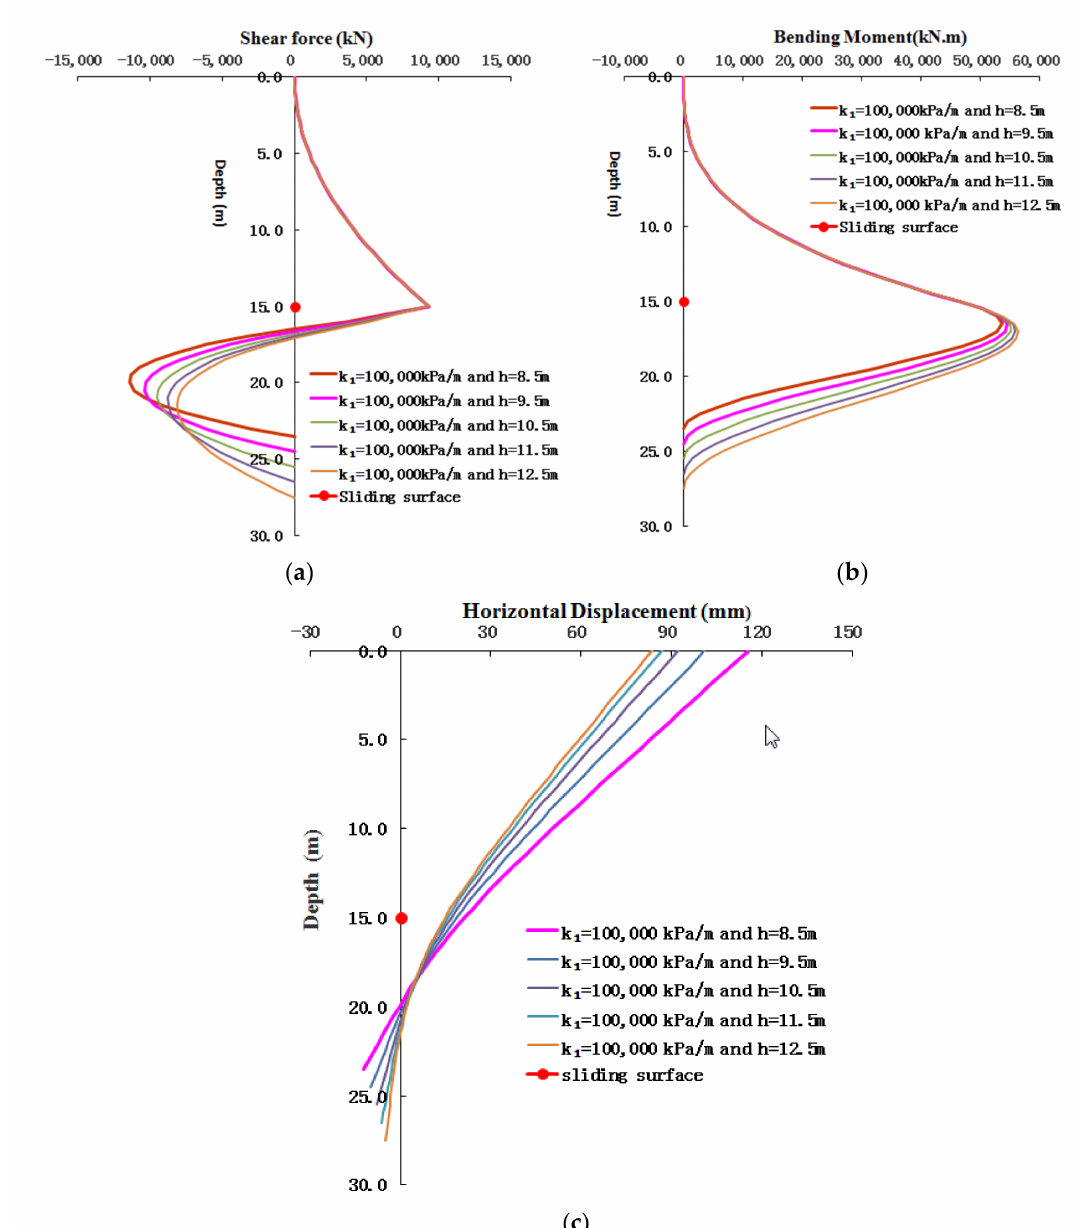
Figure9. Calculatedvaluesofinternalforcesforpilesofvariousembeddedlengthswithk 1 = 100,000kPa / m: ( a ) shear force; ( b ) bending moment; ( c ) horizontal